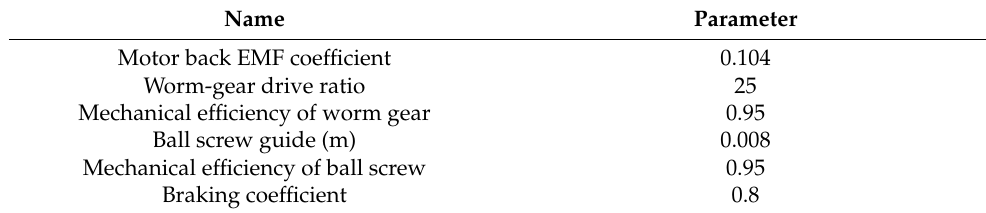
Table 3. Main parameters of implementing agencies.